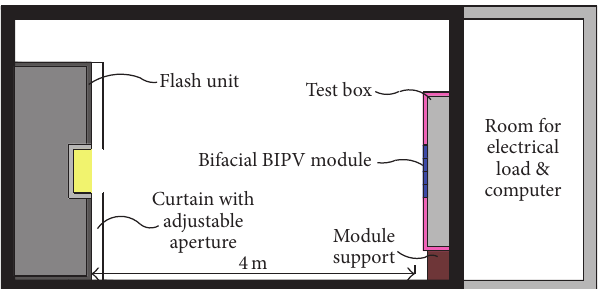
Figure 8: Conceptual view of the experimental set-up with the sun simulator test room.